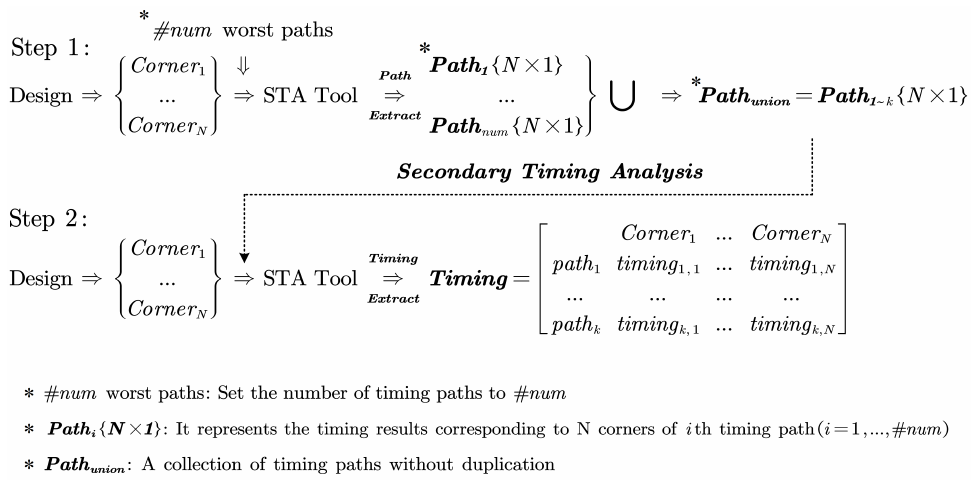
Figure 3. Data generation